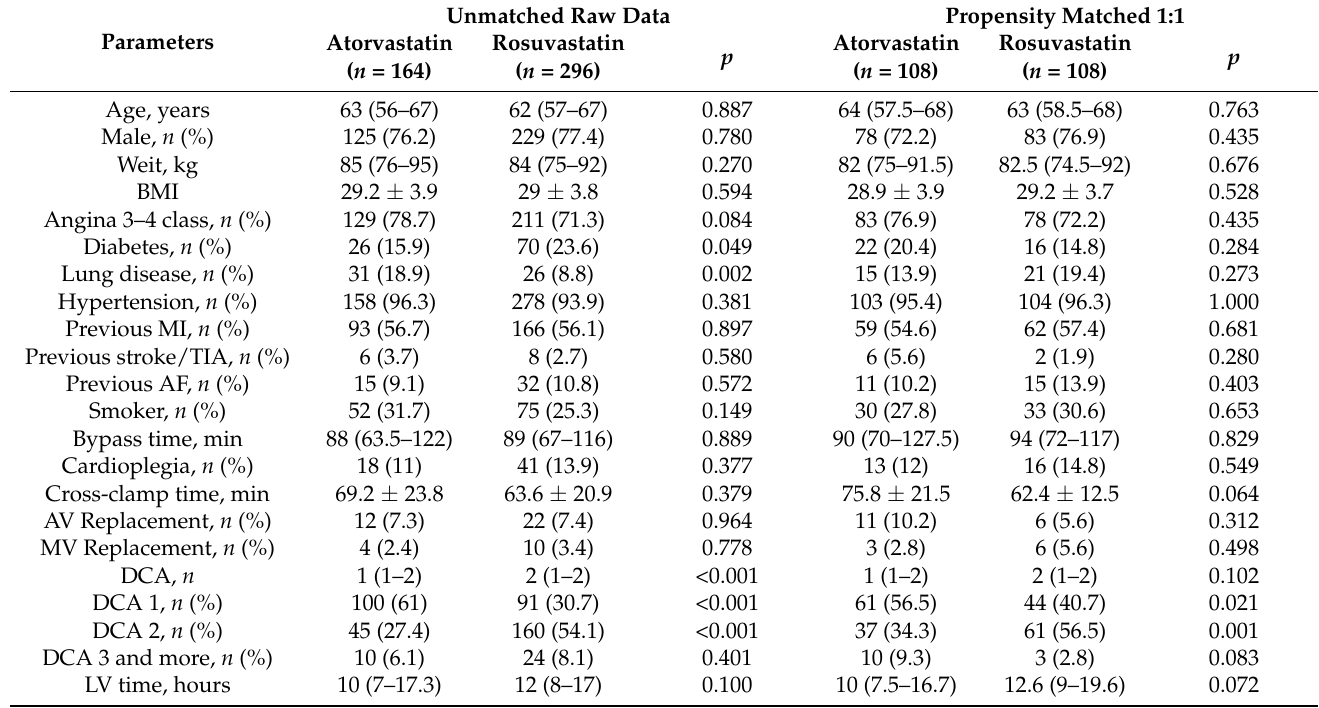
Table 1. Clinical data and operative data.